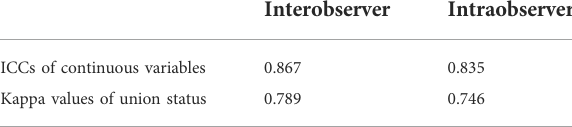
TABLE 2 Validation of measured values repeatability.